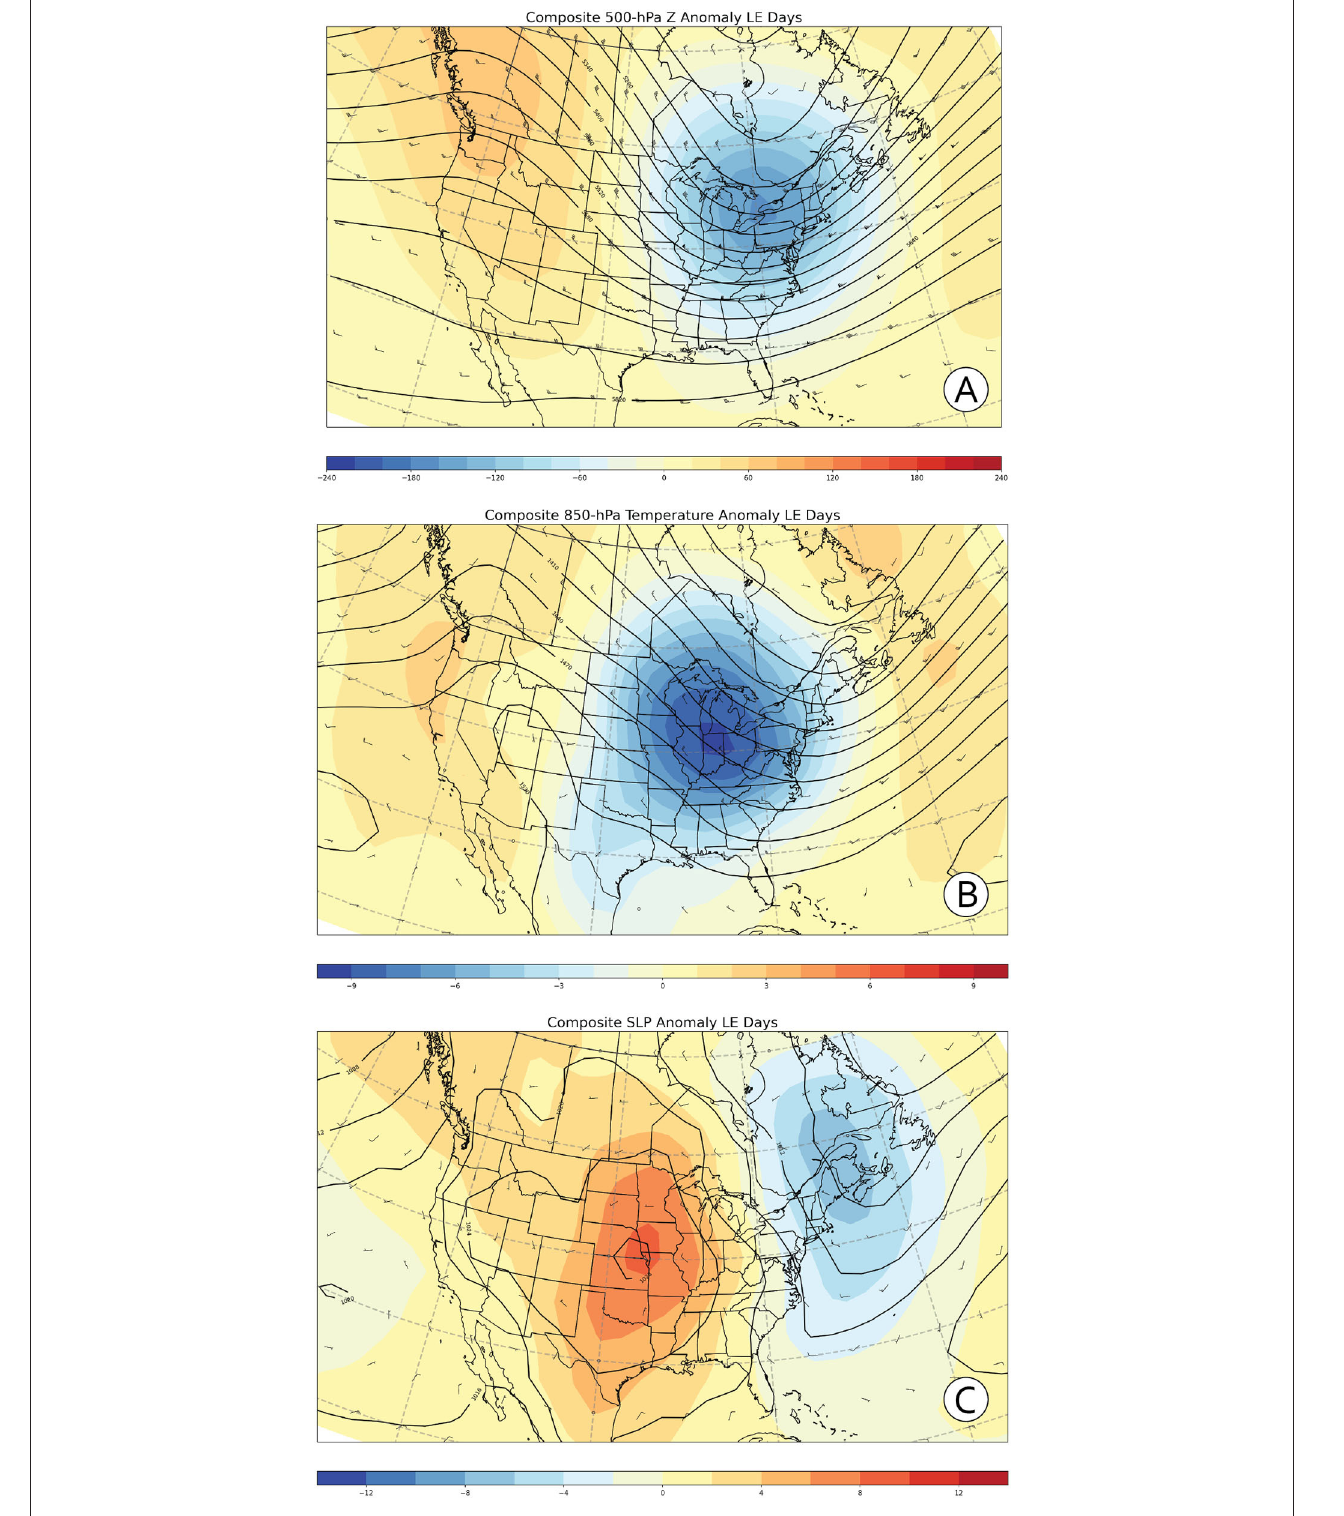
FIGURE 4 | Composite 12 UTC anomaly maps of Reanalysis I (A) 500-hPa geopotential height, (B) 850-hPa temperature, and (C) sea-level pressure for LE days. Filled contours represent anomalies of geopotential height (upper), temperature (middle) and sea-level pressure (lower), while solid contours represent mean geopotential height (upper, middle) and sea-level pressure (lower). Wind barbs are also included. There are 331 days represented within the composite. NCEI reanalysis data provided by the NOAA Earth System Research Laboratory/Physical Sciences Division, Boulder, CO from their web site (http://www.esrl.noaa.gov/psd/).